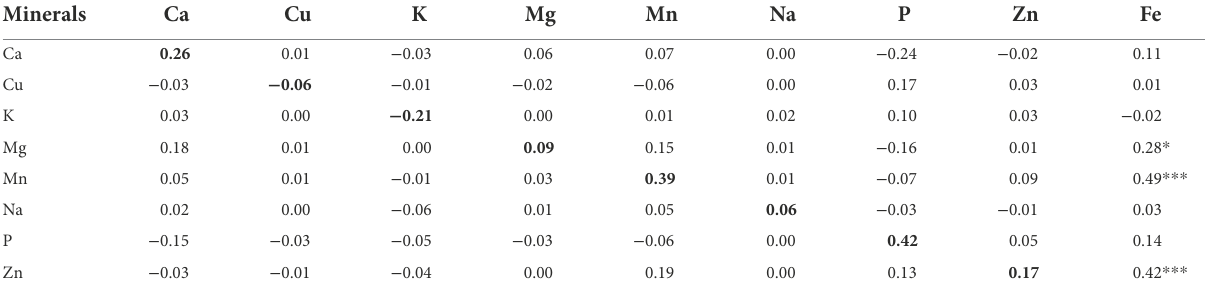
TABLE 5 The direct (bold diagonal numbers) and indirect effects of eight mineral elements on iron content in a population of 70 advanced lines of G. gynandra . Minerals